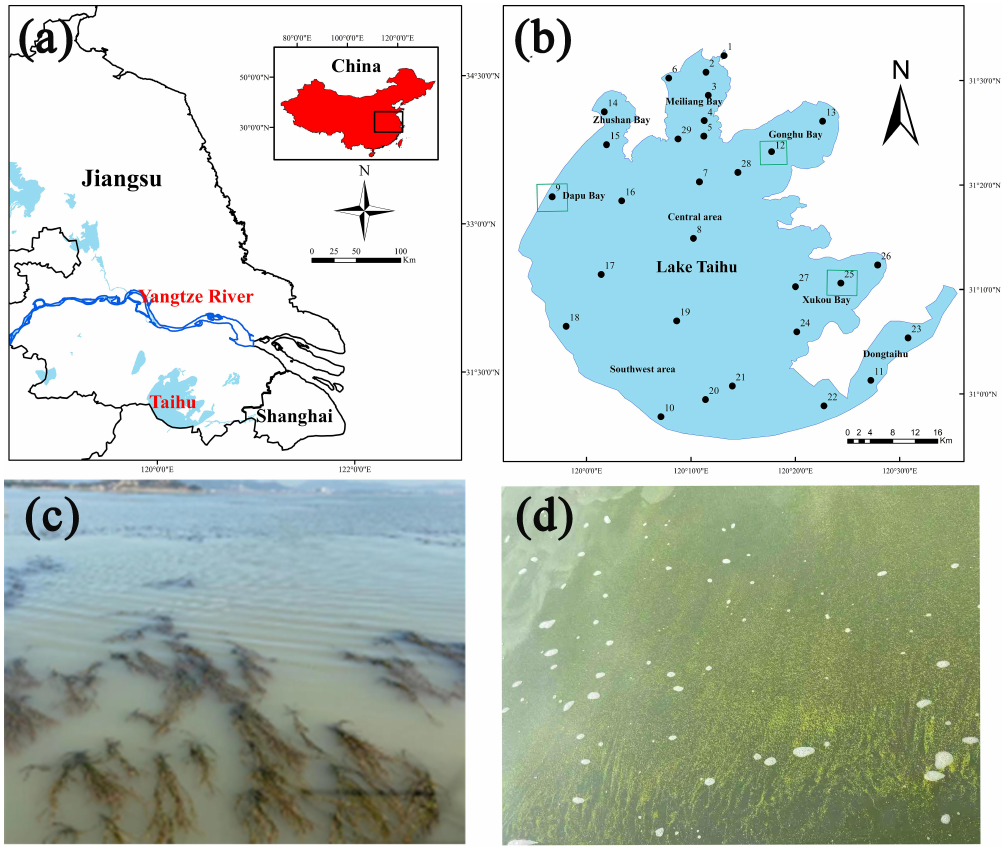
Figure 2. ( a ) The location of Lake Taihu in Jiangsu Province; ( b ) the specific distribution of sampling sites in Lake Taihu, Figure 2. A shows the location of Lake Taihu in Jiangsu Province; B represents the specific 216 where the black spots are 29 sites for surface gas collection and the green square frames are 3 points for collecting sediments; distribution of sampling sites in Lake Taihu, the black spots are 29 sites for surface gas collection, 217 ( c , d ) images of an aquatic-plant-covered area and an algal-covered area, and the green square frames are 3 points for collecting sediments. C and d are the schematic 218 diagrams of aquatic plants covered area and algal covered area, respectively 219